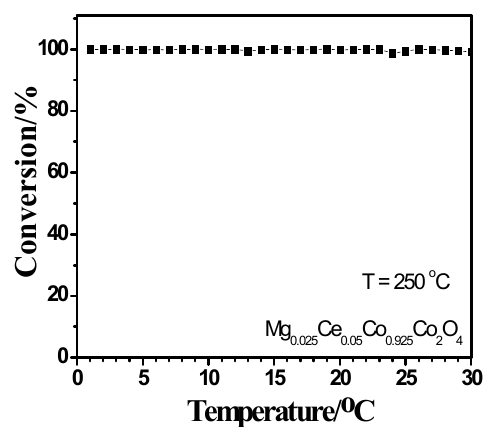
Figure 8. Long lifetime (30 h) activity measurement of N 2 O direct dissociation over Mg 0.025 Ce 0.05 Co 0.925 Co 2 O 4 at T = 250 °C. Reaction conditions: N 2 O:He = 35:65, GHSV = 30,000 h − 1